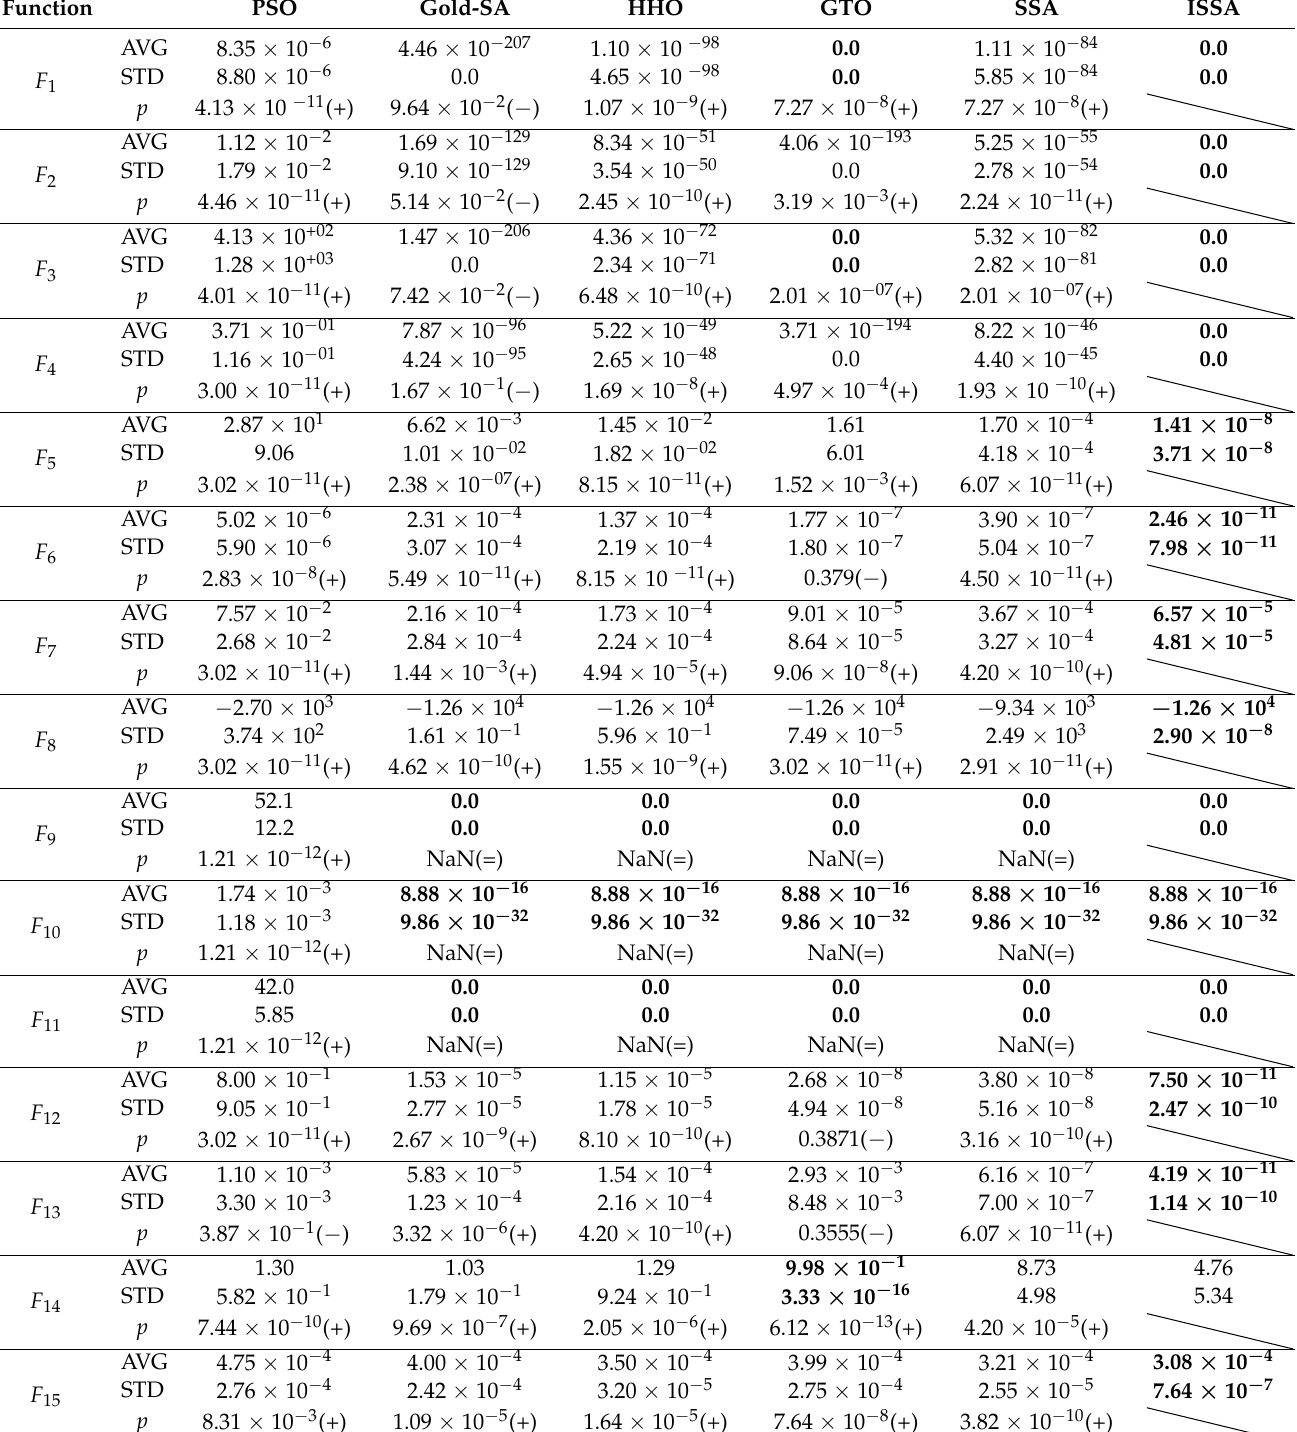
Table 2. Comparison of benchmark function results.